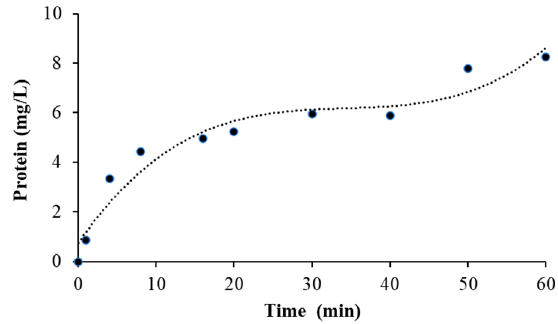
Figure 6. Desorption test for the fermPSR in phosphate buffer at 37° C with magnetic stirring of 500 rpm. 500